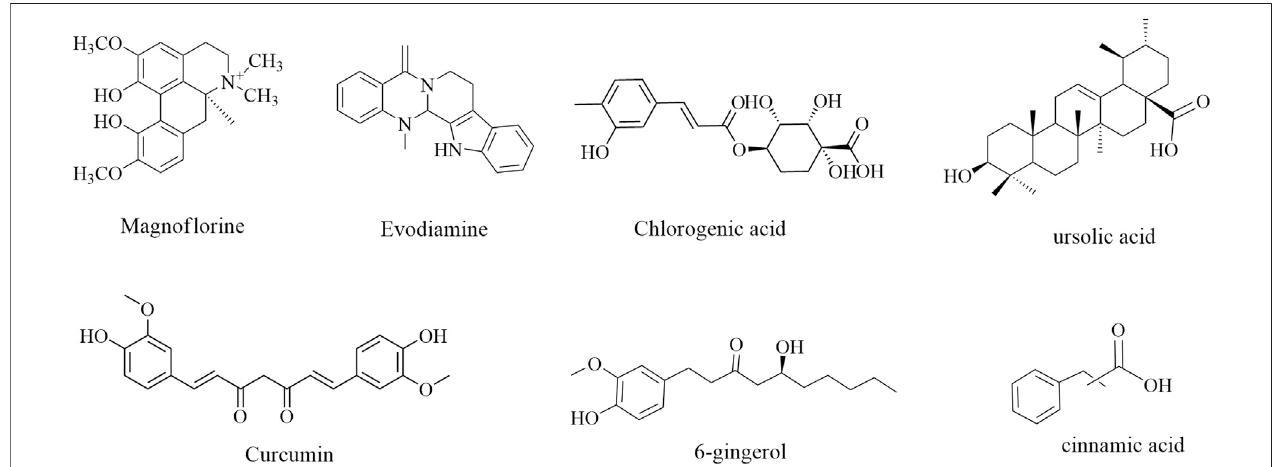
FIGURE 4 | The immune enhancement effects of alkaloids and other components in plant-based functional food.